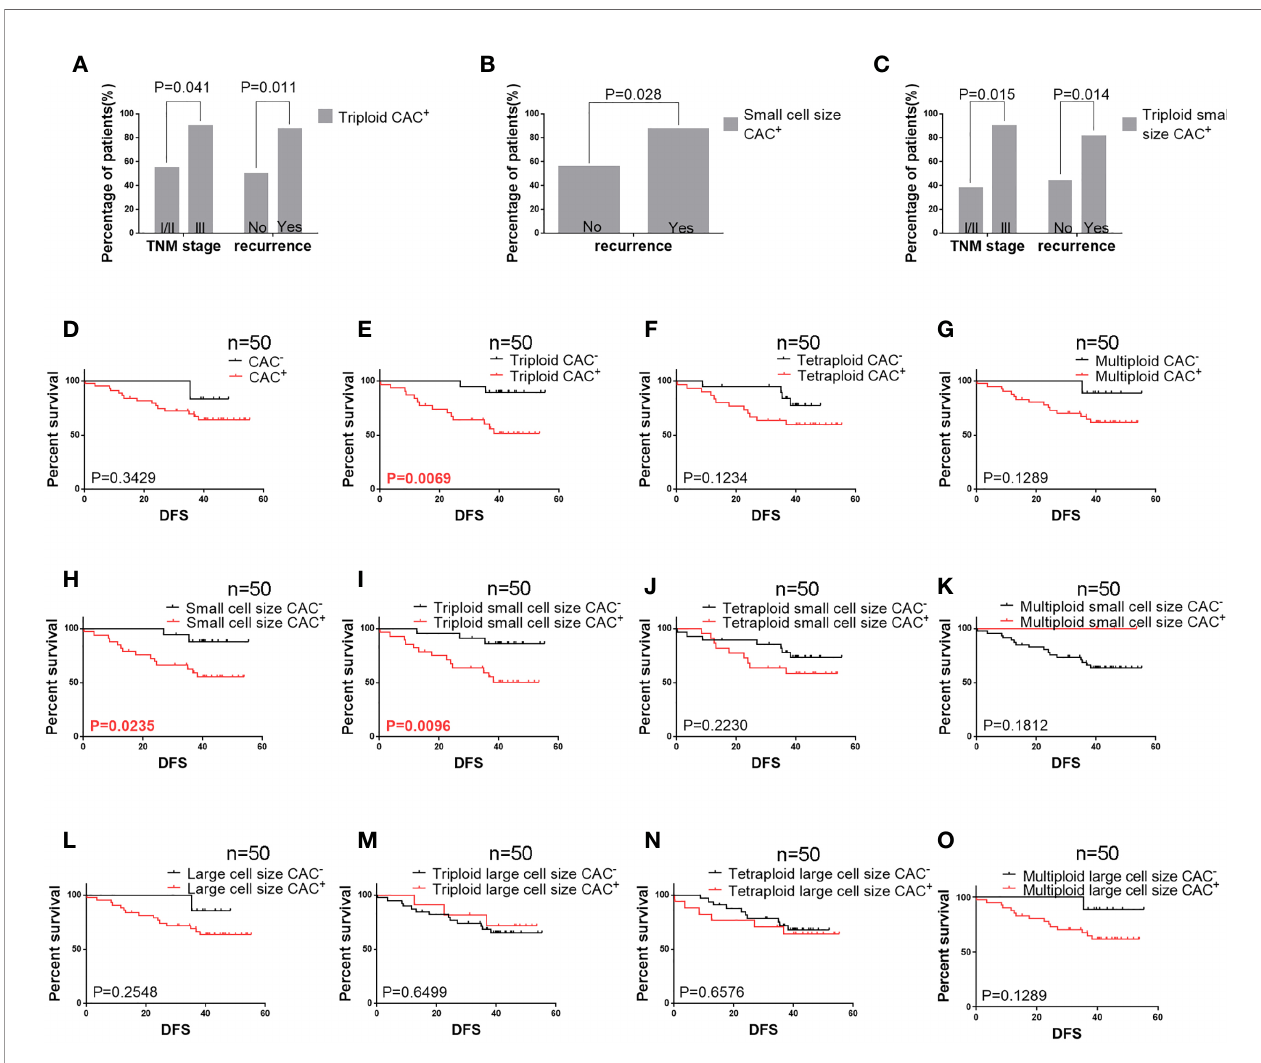
FIGURE 2 | Pre-surgery CAC analysis in 50 patients (A) Correlation of pre-surgery triploid circulating aneuploid cells (CACs) with TNM stage and recurrence. The proportion of patients who had triploid CACs was higher among those with TNM stage III and recurrence than those with TNM stage I/II and without recurrence, respectively (P < 0.05). (B) Correlation between pre-surgery small cell size CACs and recurrence. The proportion of patients who had small cell size CACs was higher among those with recurrence than those without (P < 0.05). (C) Correlation of pre-surgery triploid small cell size CACs with TNM stage and recurrence. The proportion of patients who had triploid small cell size CACs was higher among those with TNM stage III and recurrence than those with TNM stage I/II and without recurrence, respectively (P < 0.05). (D – O) Survival analysis. (D) Total CAC was not correlated to DFS (P > 0.05). (E) Patients with triploid CACs had shorter DFS compared to those without triploid CACs (P < 0.05). (F, G) Tetraploid and multiploid CAC subtypes were not correlated to DFS (P > 0.05). (H) Patients with small cell size CACs had shorter DFS compared to those without (P < 0.05). (I) Patients with triploid small cell size CACs had shorter DFS compared to those without (P < 0.05). (J, K) Tetraploid and multiploid small cell size CAC subtypes were not correlated to DFS (P > 0.05). (L – O) Total large cell size CACs and triploid, tetraploid, and multiploid large cell size CAC subtypes were not correlated to DFS (P >